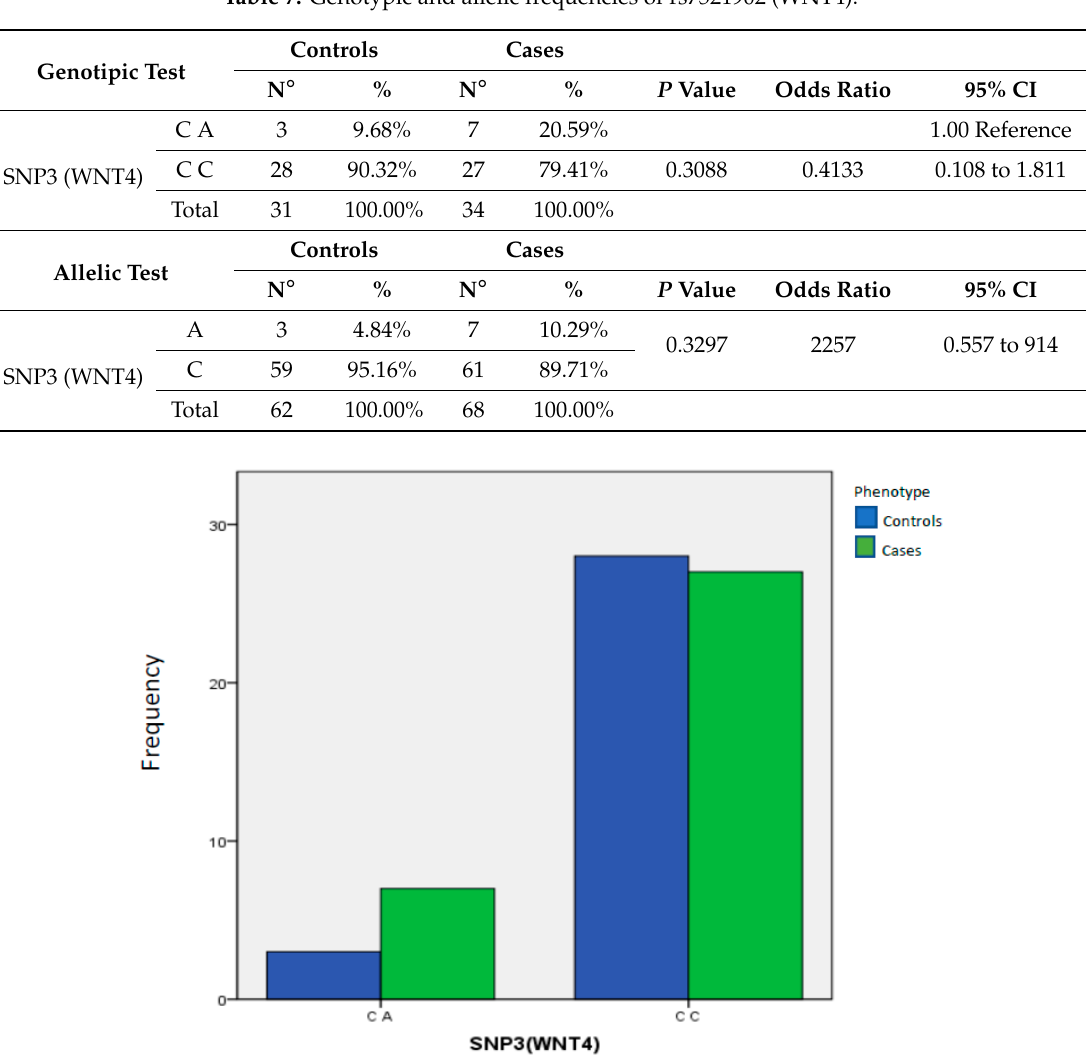
Figure 3. Distribution of CC and CA genotypes obtained for polymorphism rs7521902 (WNT4).